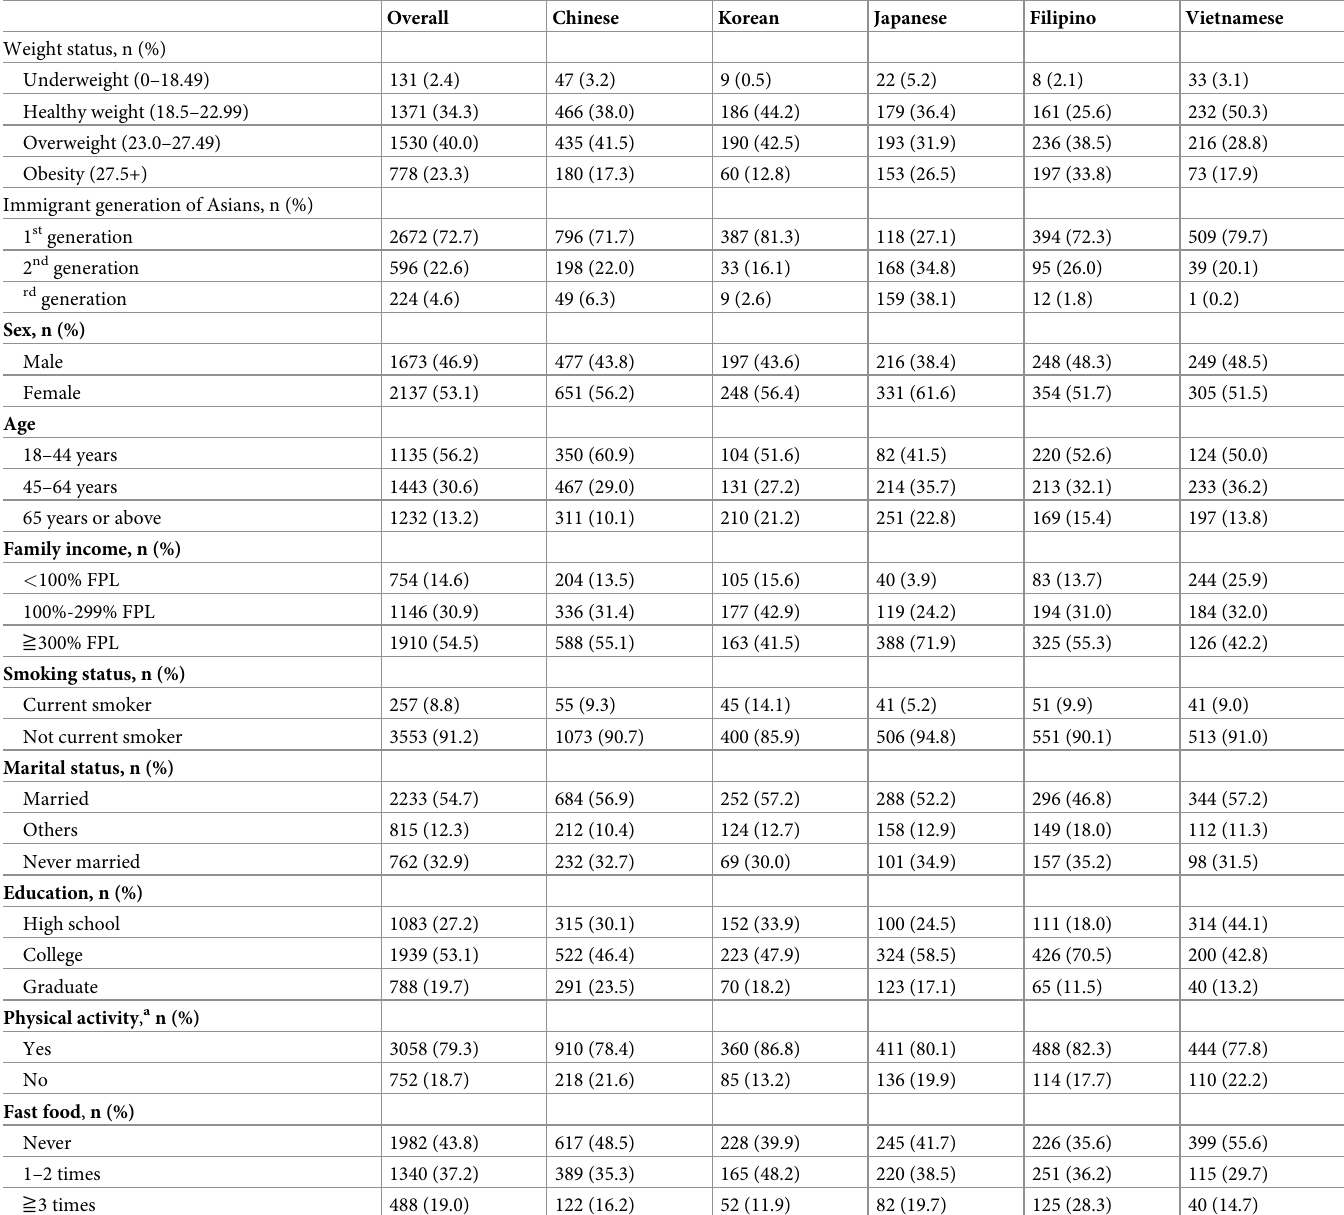
Table 1. Sample characteristics of Asian adults in California by ethnicity: CHIS 2013–2014 (n =